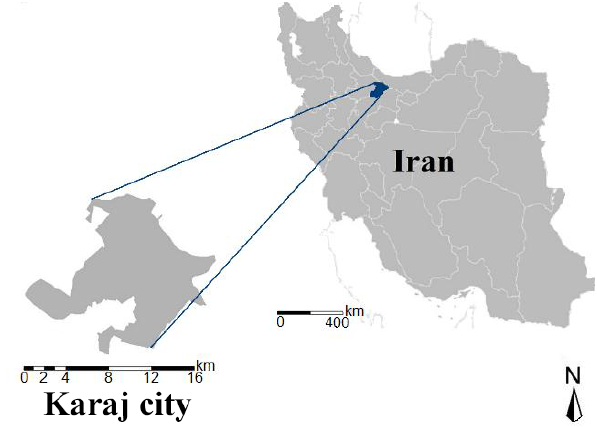
Figure 1. The location of the city of Karaj in